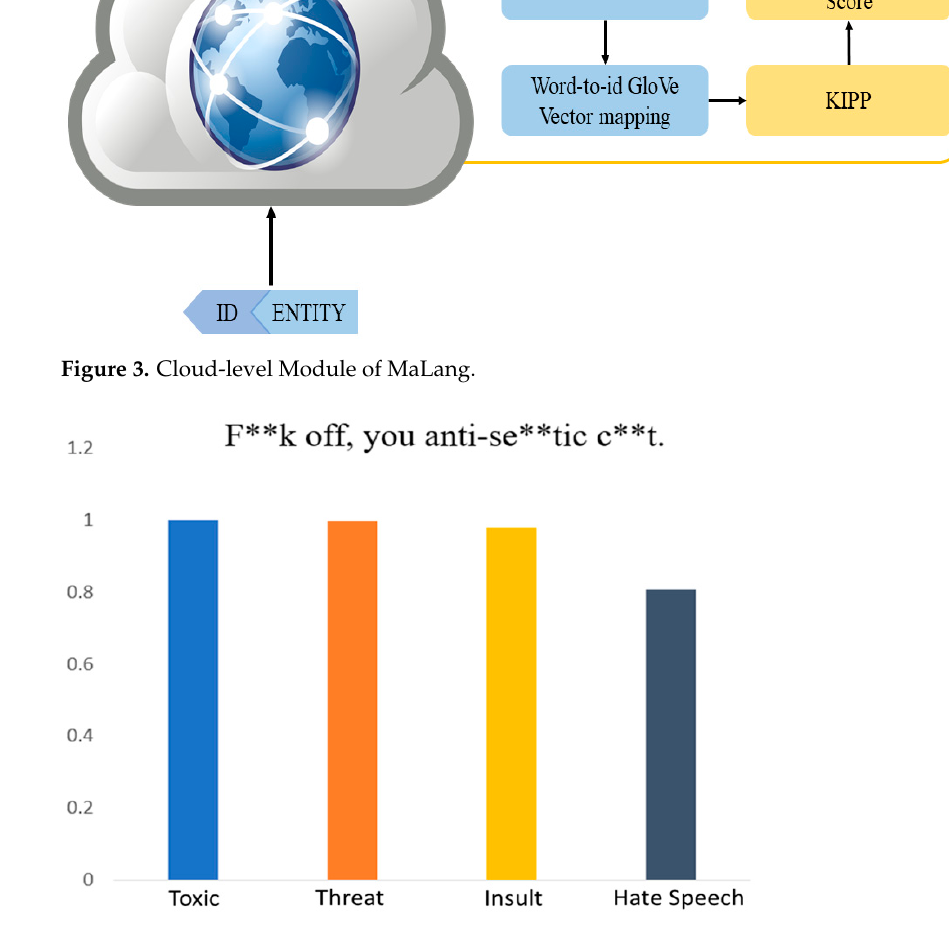
Figure 4. Probability of the presence of different types of toxic content.